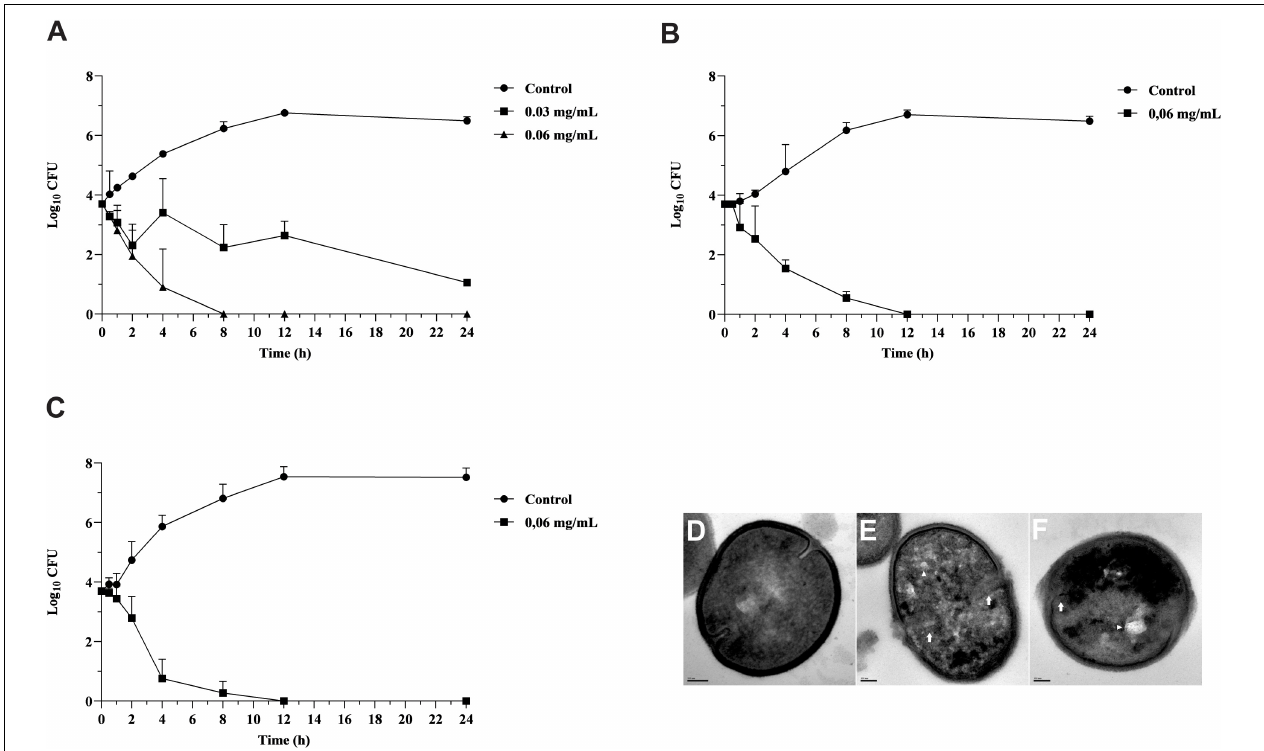
FIGURE 1 | Antibacterial effect of oleoresin from Copaifera officinalis on growth and morphology of planktonic cells of Streptococcus agalactiae . Time-kill curve of S. agalactiae ATCC 13813 (A) , erythromycin and clindamycin-resistant GBS 66 strain (B) , and erythromycin-resistant GBS 121 strain (C) in presence of copaiba oil. Bacteria were incubated with copaiba oil at MIC (0.03 or 0.06 mg/mL) and MBC (0.06 mg/mL) for 24 h at 37 ◦ C and the CFU counts per 10 µ L were determined at specified time points. GBSs without treatment were used as growth control. Values are mean ± standard deviation of two experiments. Transmission electron microscopy images of untreated S. agalactiae ATCC 13813 exhibiting typical spherical morphology, continuous cell wall and regular electron density (D) . The treatment with copaiba oil at MIC (E) , and MBC (F) for 2 h resulted in disruption of cell wall (white arrow), intracellular condensed material (arrowhead), and electron density decreasing. Bar: 100